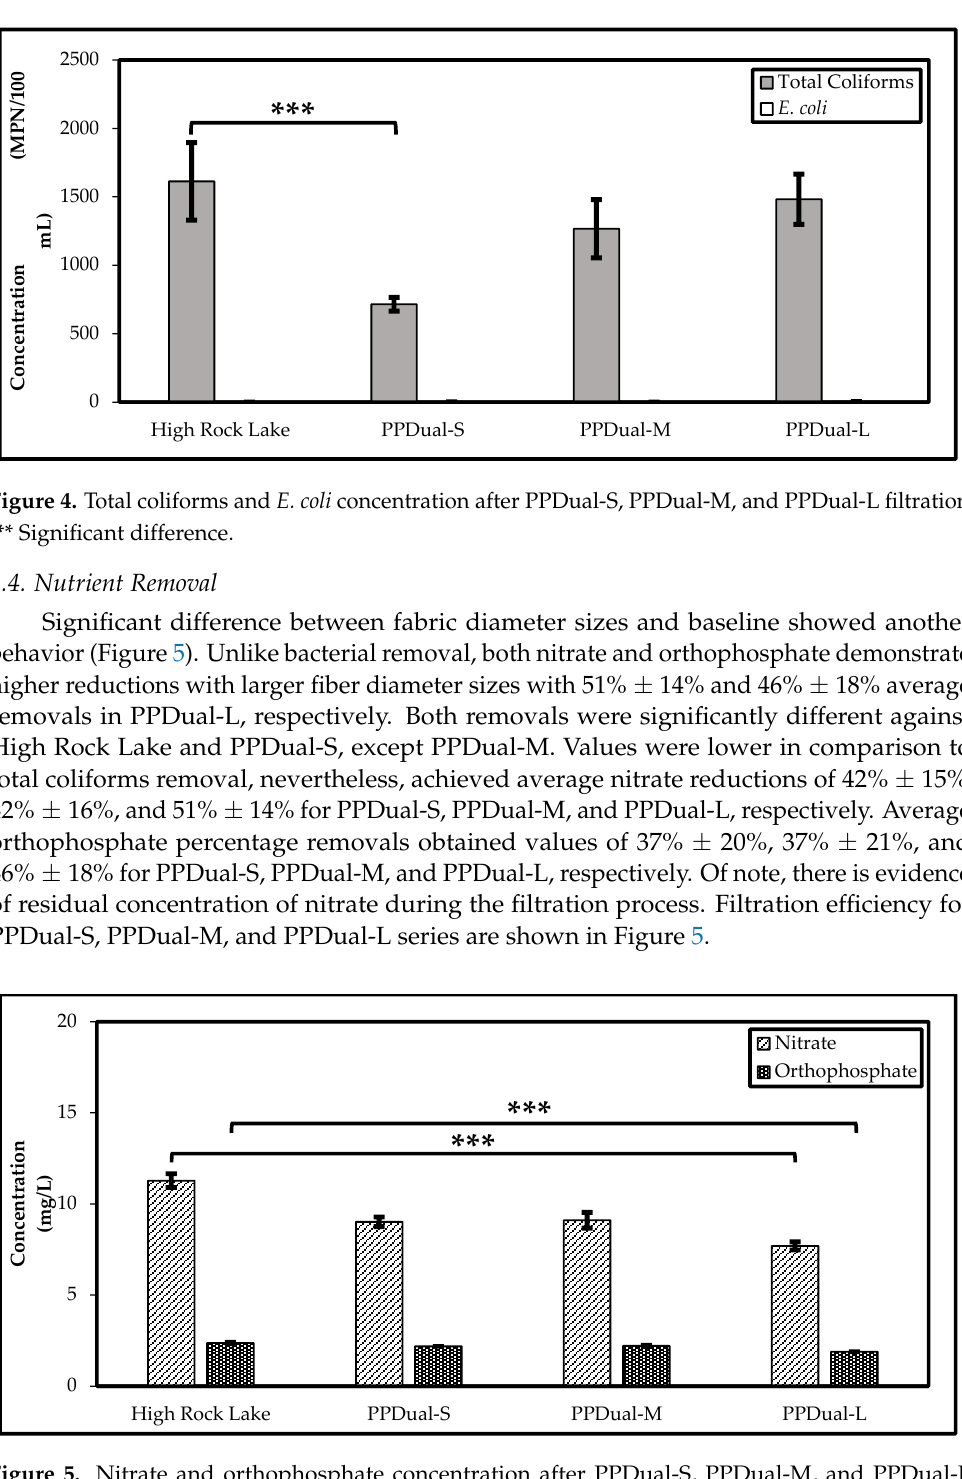
Figure 5. Nitrate and orthophosphate concentration after PPDual-S, PPDual-M, and PPDual-L filtration. *** Significant difference.